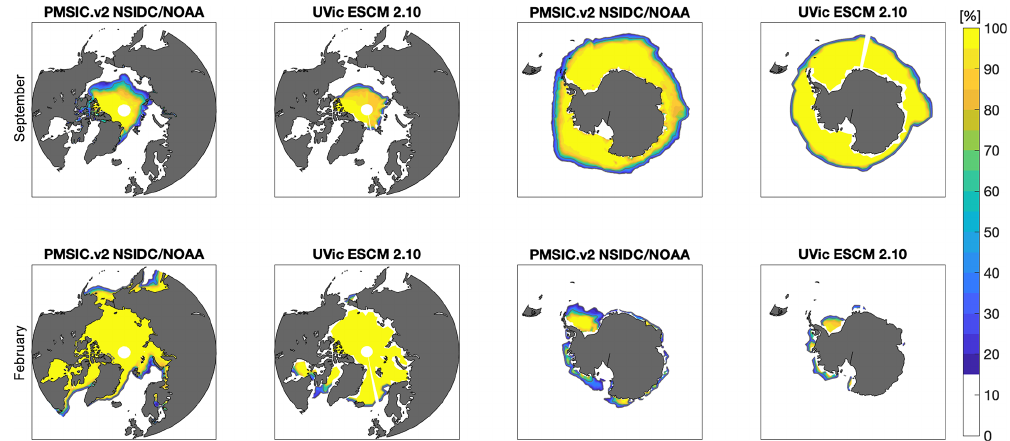
Figure 4. September (top row) and February (bottom row) sea ice concentrations from passive microwave observations (Meier et al., 2013) and the UVic ESCM 2.10 for the Northern Hemisphere and Southern Hemisphere for the period of 2003–2013 (in